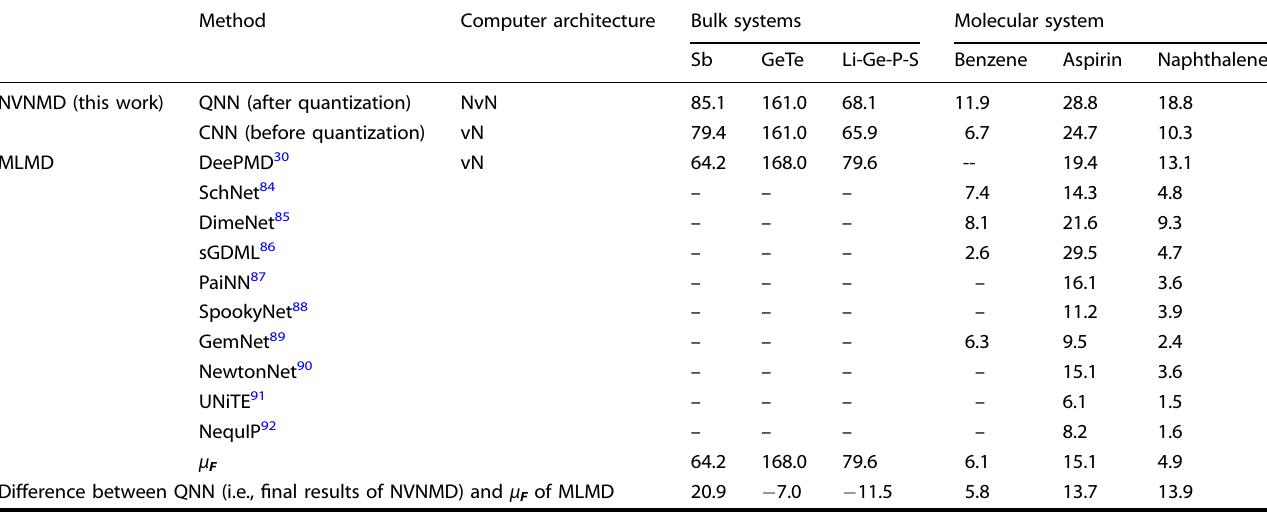
Table 3. The mean absolute error (MAE) of atomic forces (meV Å − 1 ) of three bulk systems and three molecular systems.